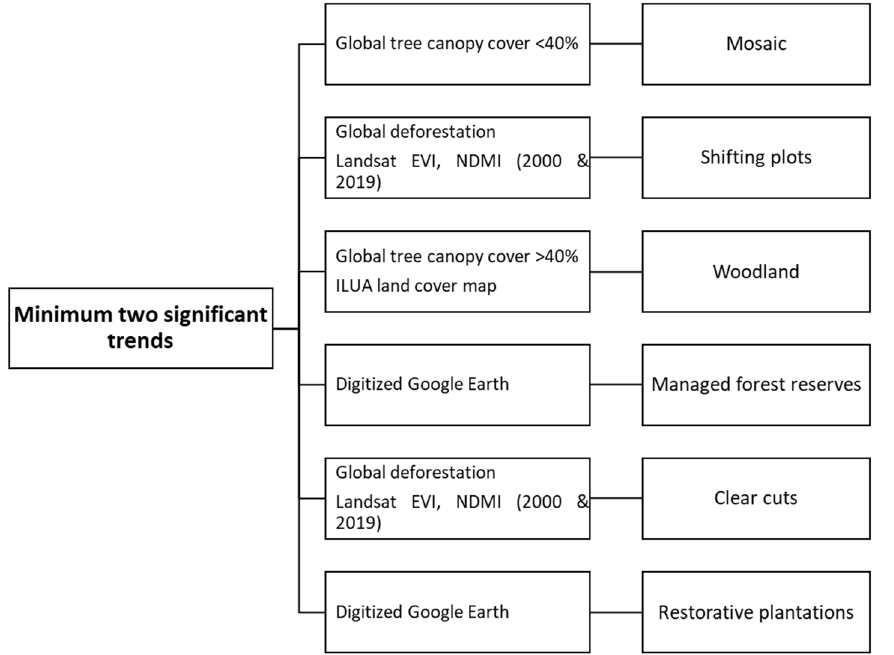
Figure 2. Systematic scheme used to assign land use type. “Minimum two significant trend” means the trend map with pixels having two and three significant trend patterns. Table 2. Framework for assigning land use